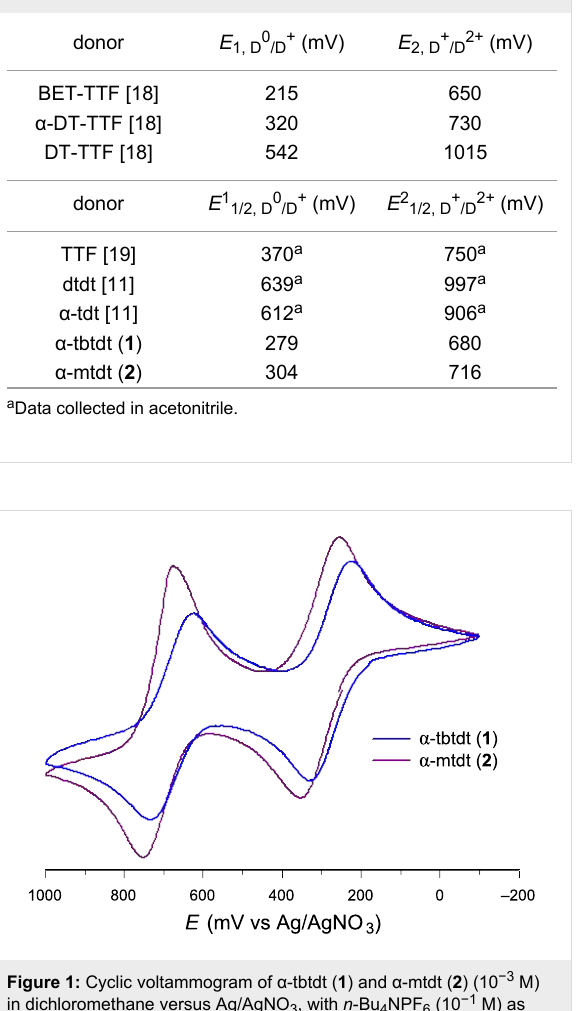
Table 1: Electrochemical data (oxidation potentials E and half wave potentials E 1/2 for quasi reversible processes), vs Ag/AgNO 3 in DCM, of TTF derivatives 1 and 2 as well as of the related donors.